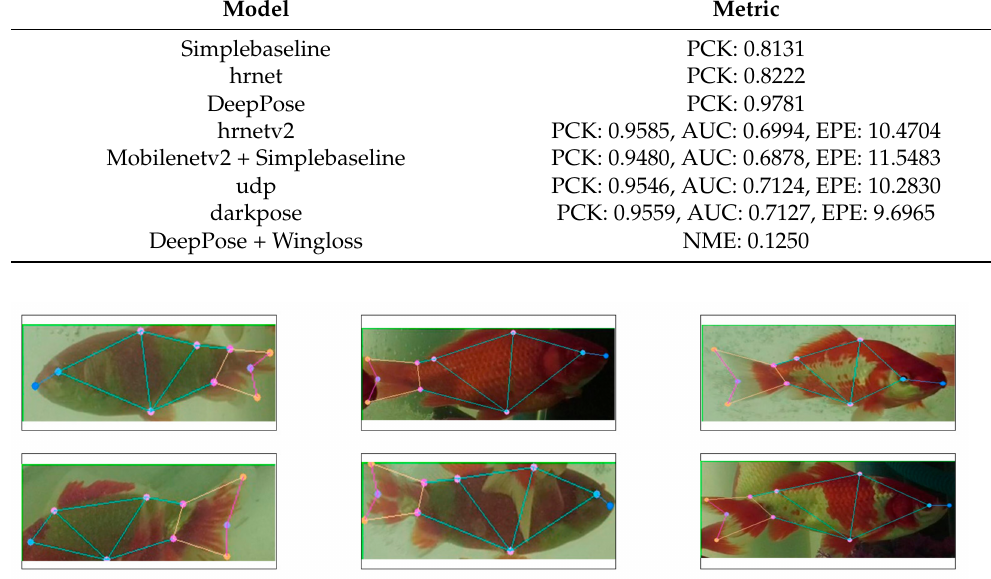
Figure 15. Final effect